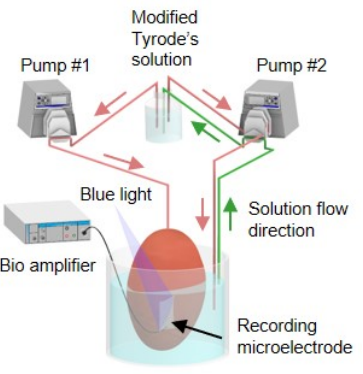
Figure 5. Schematic demonstration of the Langendorff perfusion experimental setup for co-localized electrophysiological recording and optogenetic pacing of a mouse heart.